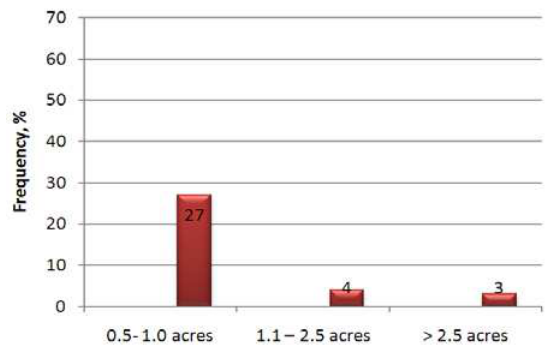
Fig. 4. Plot size distribution